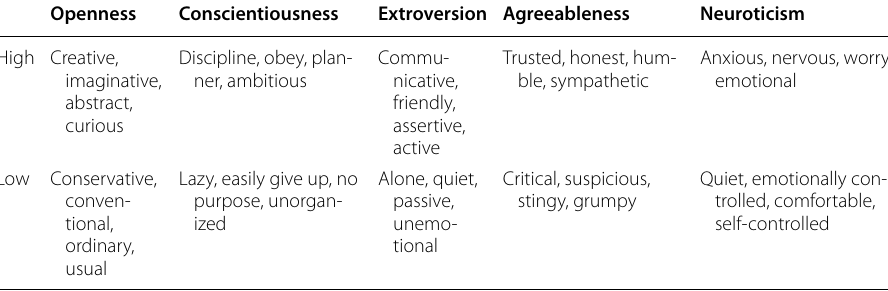
Table 1 Big five personality traits characteristic [1]